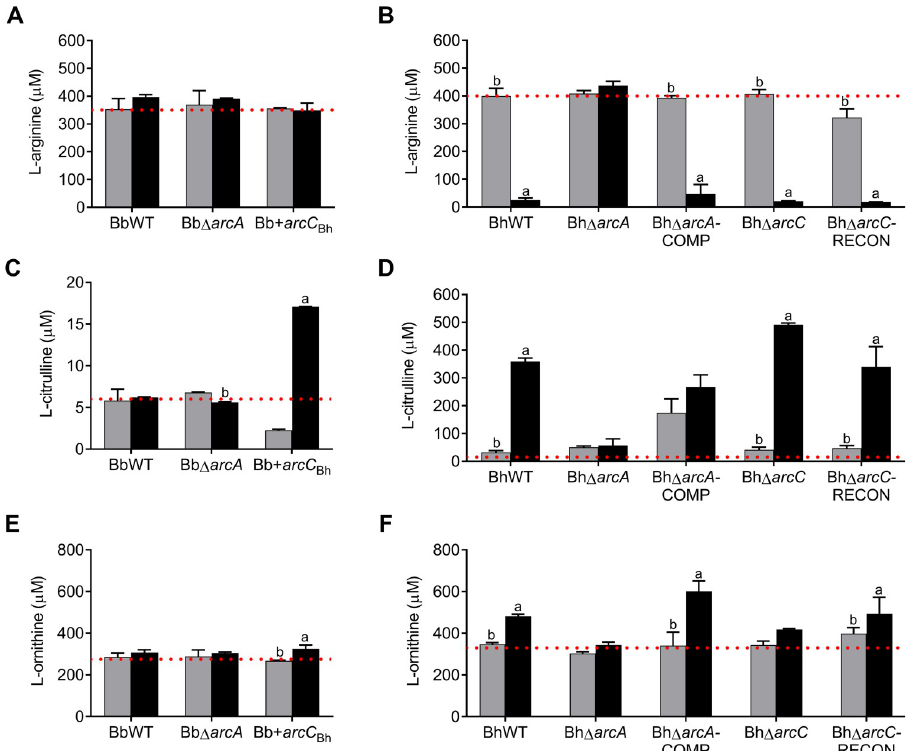
Fig 4. L-arginine utilization requires arginine deiminase expression during in vitro growth. B . burgdorferi (A, C, and E), B . hermsii (B, D, and F), and ADI mutant strains were grown to 5 x10 7 (gray bars represent mid-logarithmic phase) and > 1 x 10 8 (black bars represent stationary phase), and supernatants from each culture were assayed for metabolite consumption and/or appearance. B . burgdorferi was grown in BSK II and B . hermsii in BSK X. Dotted line represents amino acid concentration in uninoculated growth medium (n = 3). Letters indicate statistical significance p- value < 0.05 in a two-way ANOVA with Dunnett’s multiple comparison test: (a) mid-logarithmic phase, (b) stationary